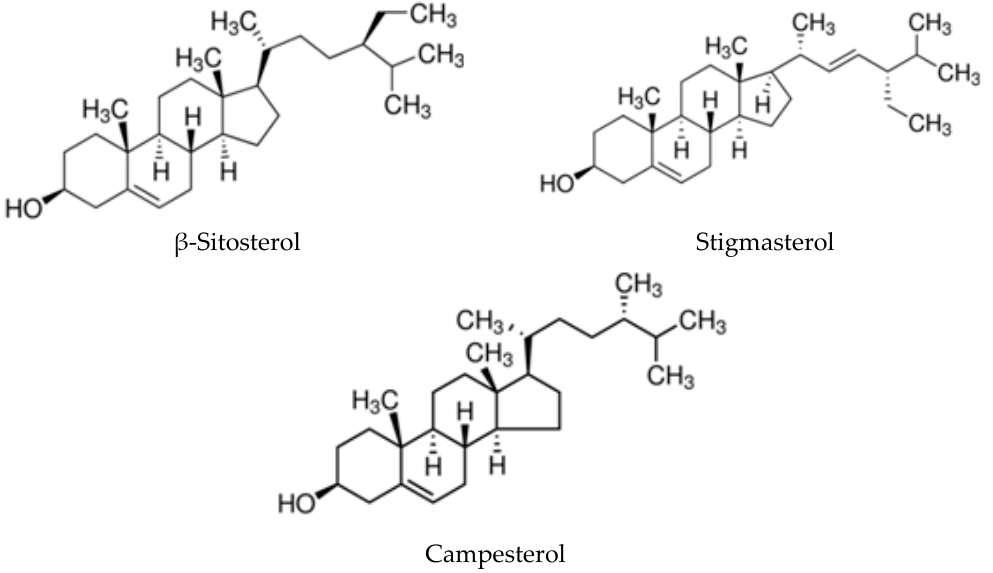
Figure 1. Chemical structure of the three most representative phytosterols in vegetable oils.